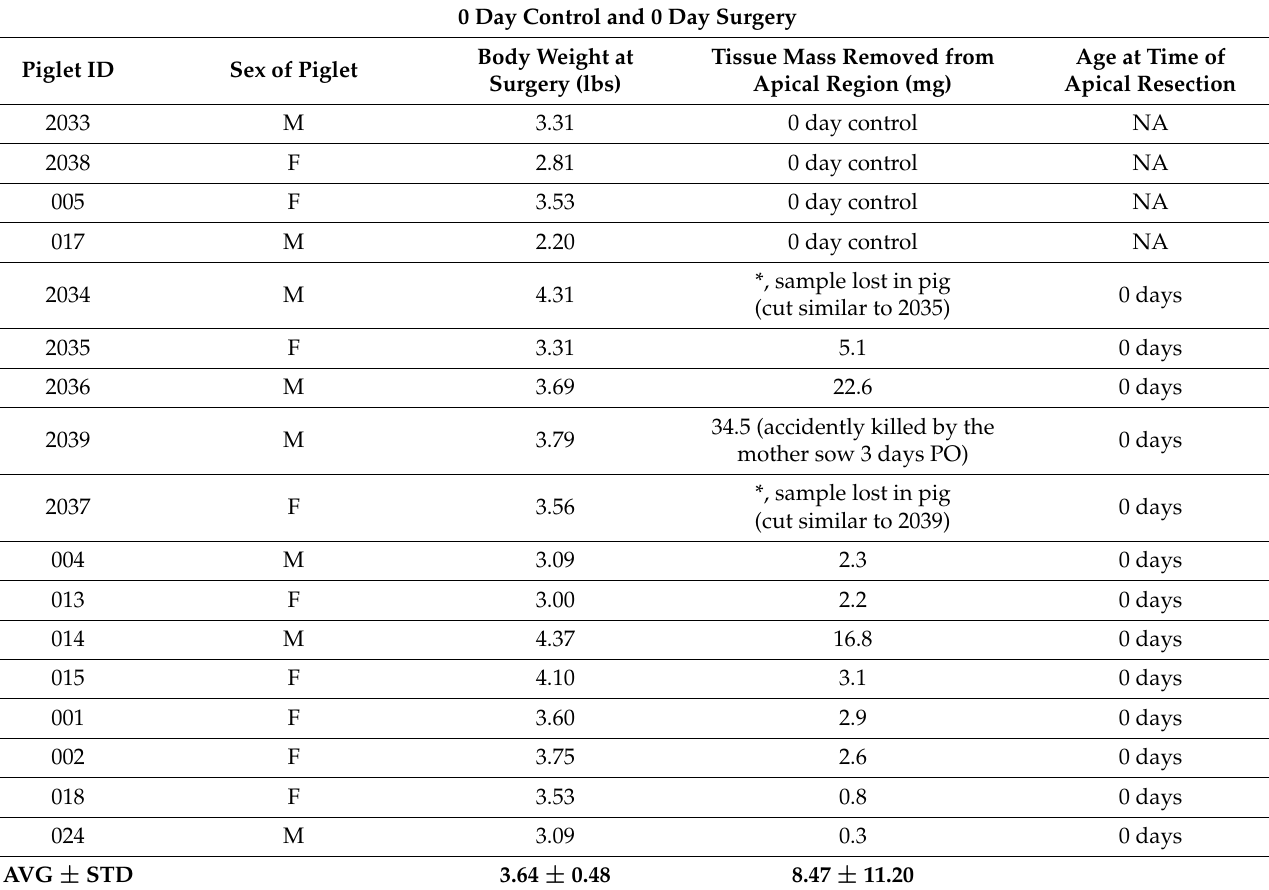
Piglet ID Sex of Piglet